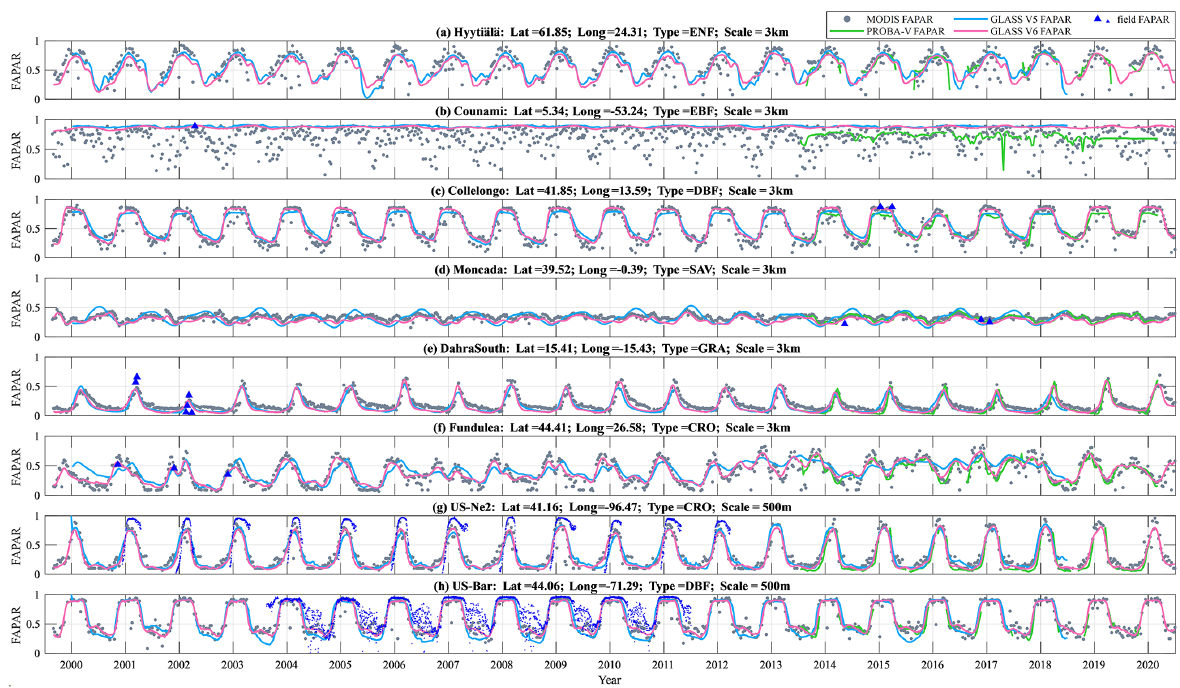
Figure 9. (a–f) Aggregated 3km time series of MODIS, GLASS V5, GLASS V6, and PROBA-V FAPAR products at six DIRECT sites with